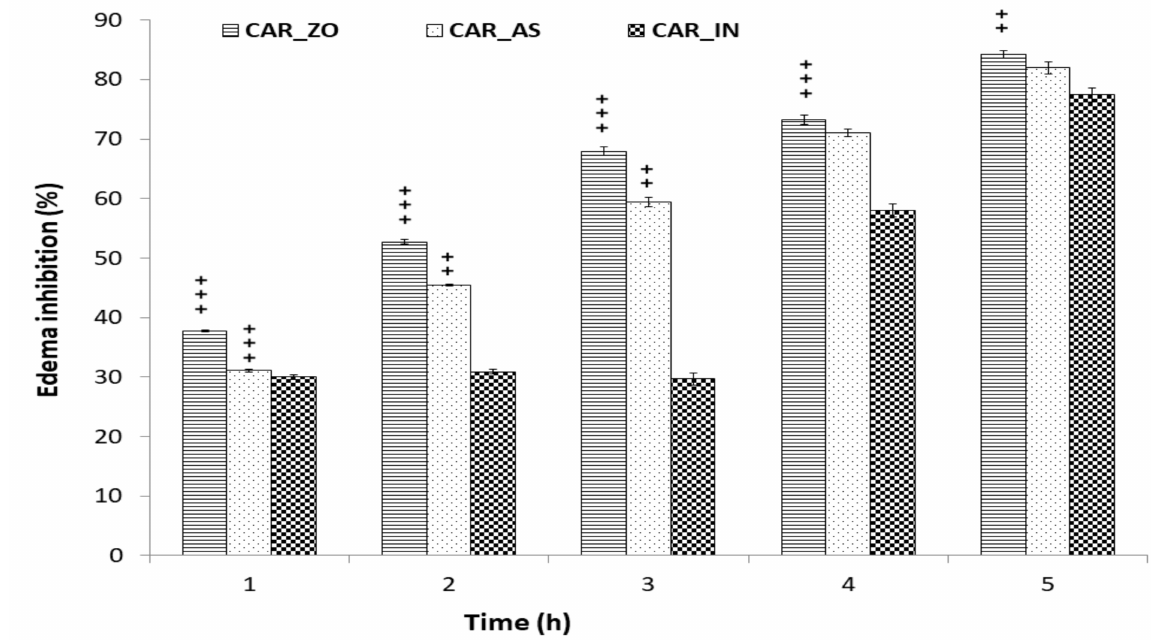
Figure 2. Percentage of inhibition of edema produced by ZO, AS and IN alone at various time intervals of CAR-induced rat paw edema: CAR_ZO: rats pre-treated with ZO for 7 days before CAR injection; CAR_AS: rats treated with AS after CAR injection and CAR_IN: rats treated with IN after CAR injection. Values are expressed as mean ± SEM. Values are expressed as mean ± SEM. Symbols ( + ) exhibit significant statistical differences between the groups. + p < 0.05; ++ p < 0.01 and +++ p < 0.001 versus CAR_IN